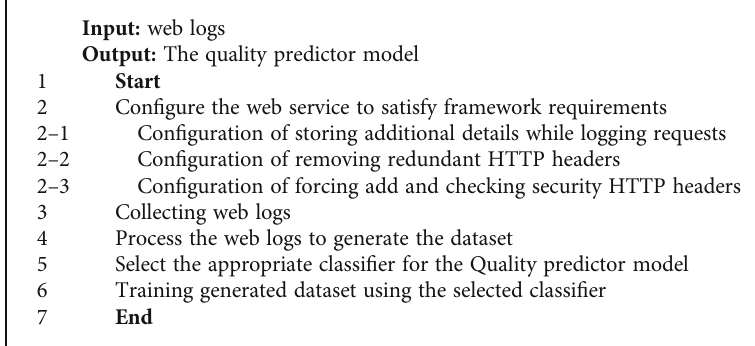
Algorithm 1: Quality predictor model implementation.